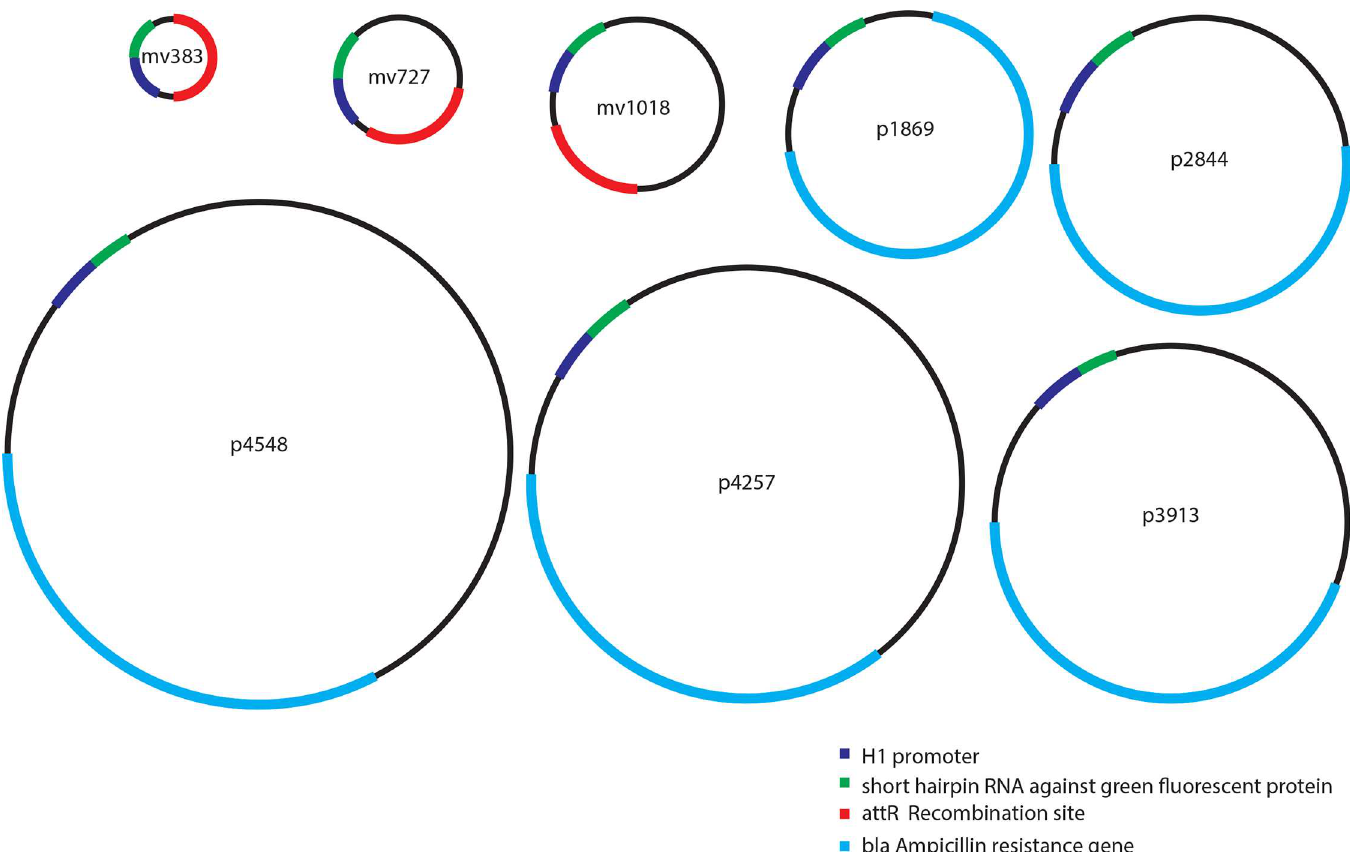
Fig 1. Schematic of DNA vectorstested. Vectors are drawn to relative scale. p = plasmid; mv = minivector. The numbersdenote length in base